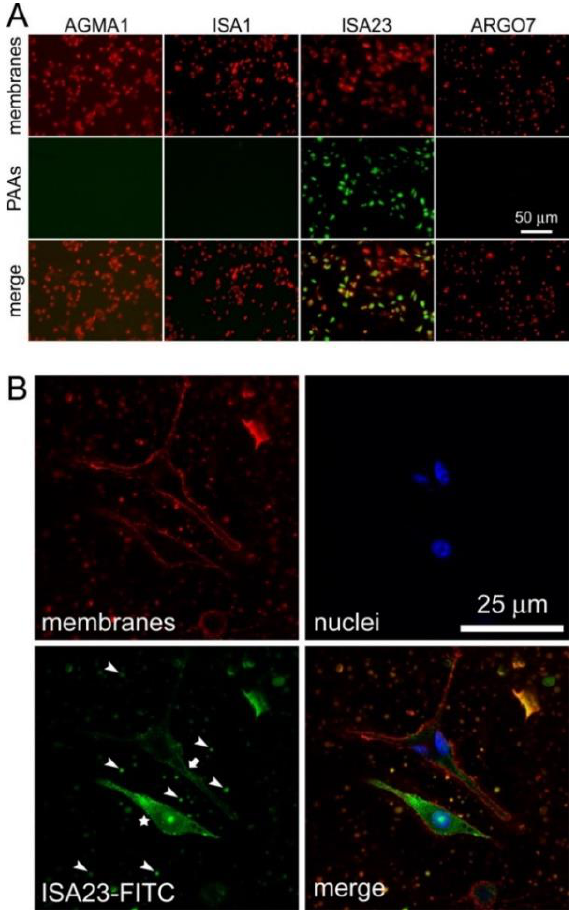
Figure 3. Fluorescence microscopy analysis of PAA-FITC uptake by macrophages. ( A ) Conventional fluorescence microscopy of all PAA samples. ( B ) Confocal fluorescence microscopy of the ISA23-FITC sample. Two macrophages are shown, one with intense intracellular FITC labeling (star) and another with plasma membrane labeling (arrow). Arrowheads point at some of the abundant vesicular structures present in the culture that have also incorporated the polymer.